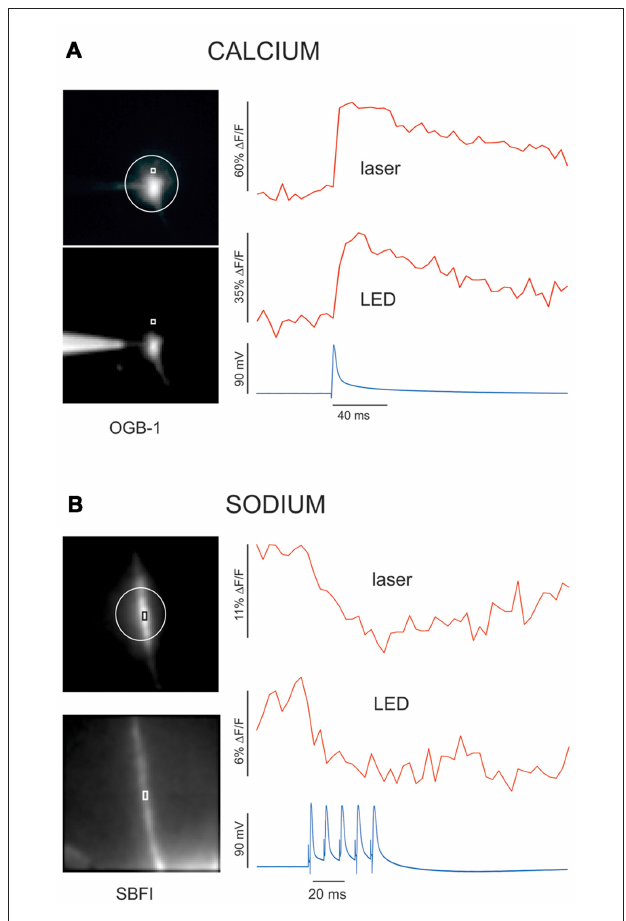
FIGURE 6 | The fractional change in fluorescence ( ∆ F/F) is greater using a laser spot compared to when illumination is with an LED. Using a laser in one channel and an LED in the other, [Ca 2 + ] i or [Na + ] i changes were measured in alternate channels. The calcium signals (using OGB-1, 200 µ m fiber, and 20 × lens) in response to a single bAP were measured from a dendritic location in one cell (A) and the sodium signals (using SBFI, 200 µ m fiber, and 60 × lens) in response to five APs were measured from the axon of another cell (B) . In each case the laser and LED signals were measured simultaneously in the two channels. For both the sodium and calcium signals the peak ∆ F/F response was about twice as large using the laser. Resting fluorescence levels (F) were about the